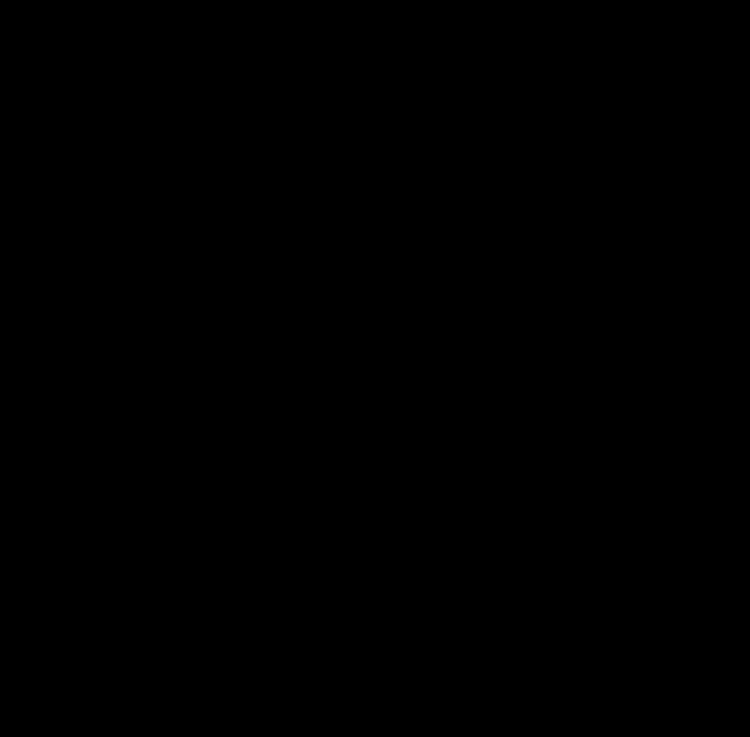
Conversion simulation model of each function. (For interpretation of the references to color in this figure, the reader is referred to the web version of this article.)